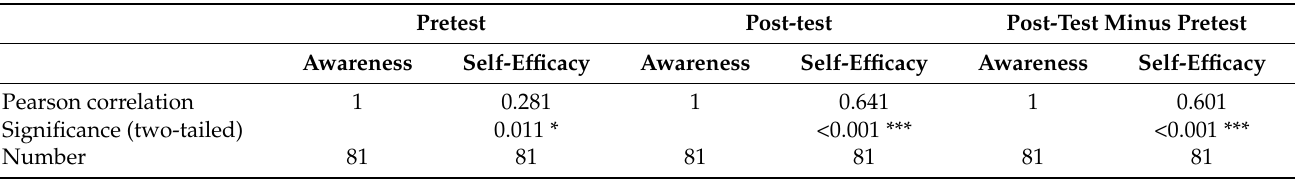
Table 7. Correlation analysis between awareness of fire prevention and emergency response and self-efficacy (N =